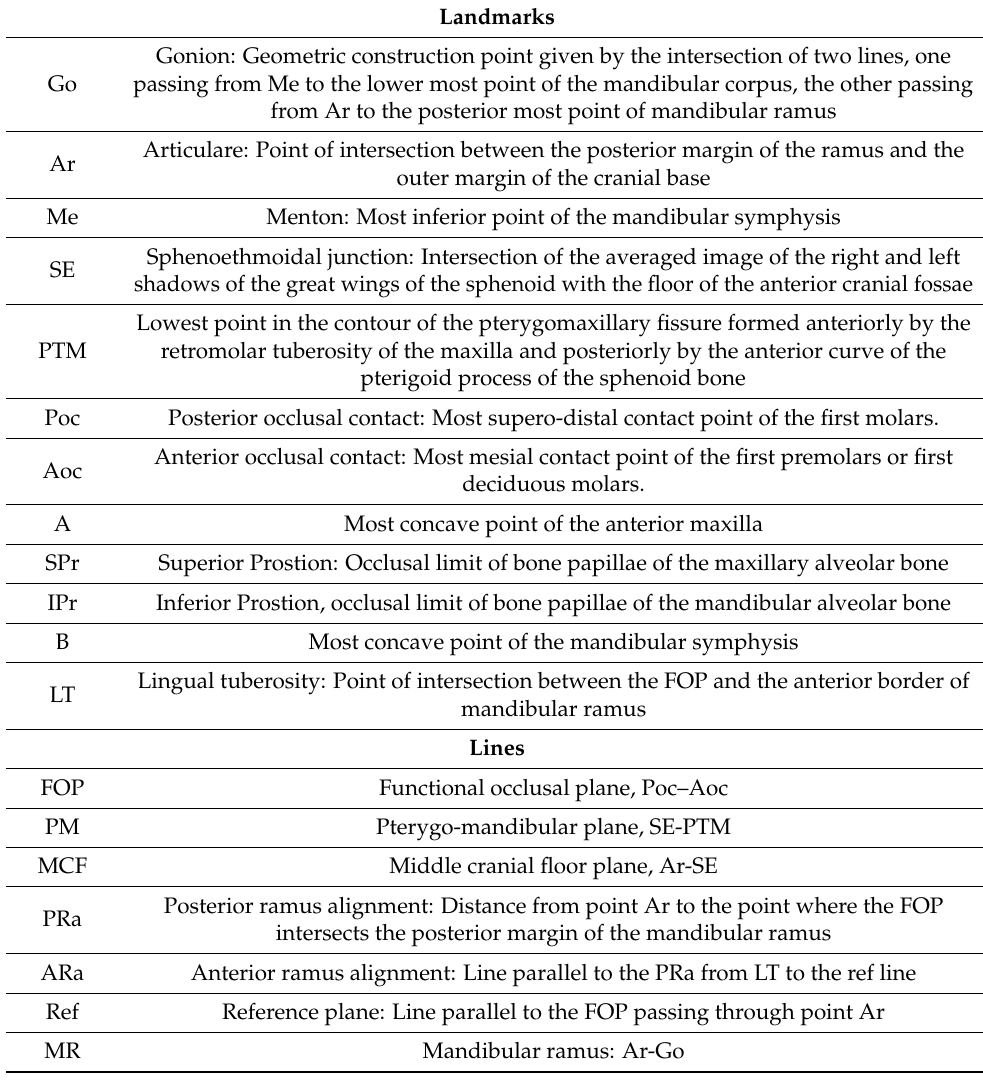
Table 1. Landmarks and lines identified in the 2D simplified Enlow’s analysis.